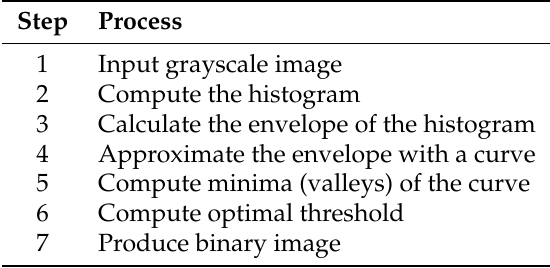
Table 1. Flowchart of the proposed